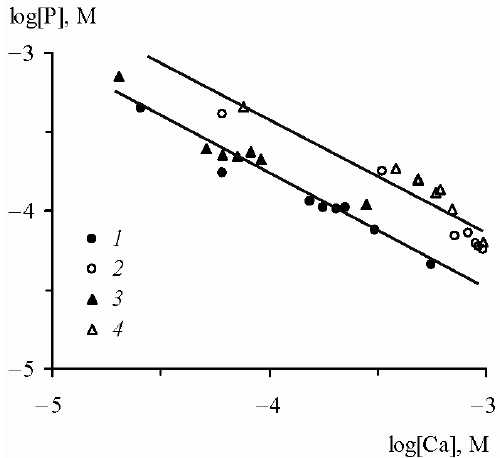
Figure 2. Relationship between logarithms of the concentrations of dissolved phosphates and calcium in the interaction of FePO 4 and AlPO 4 with fresh waters [17]. FePO 4 : ( 1 ) water from the Moscow River, ( 2 ) water from the Don River mouth; AlPO 4 : ( 3 ) water from the Moscow River, ( 4 ) water from the Don River mouth.